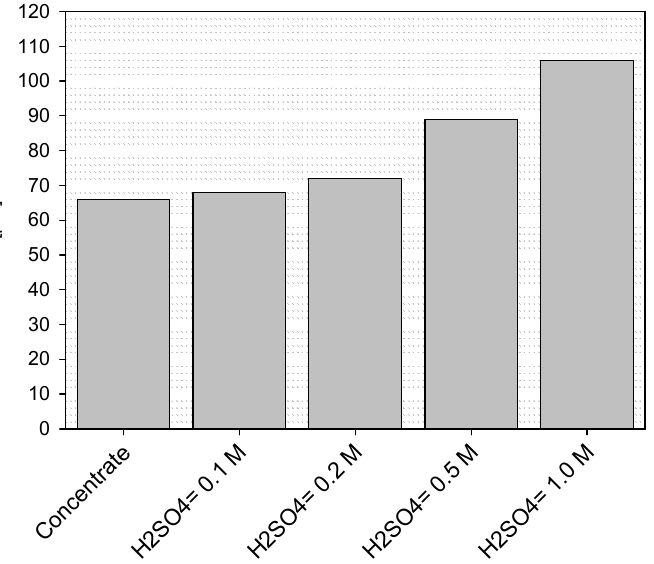
Figure 19. FBRM analysis of the growth of grains belonging to residues using different concentrations of H 2 SO 4 .